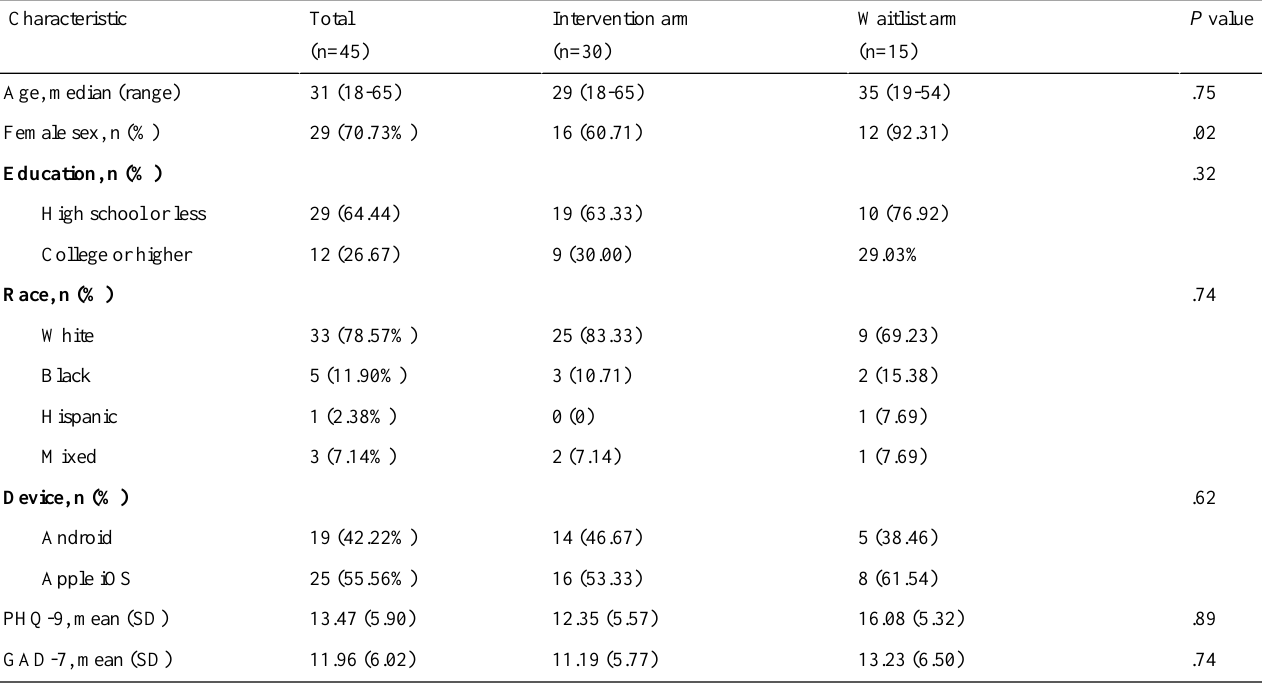
Table 1. Demographic and baseline characteristics of study participants.